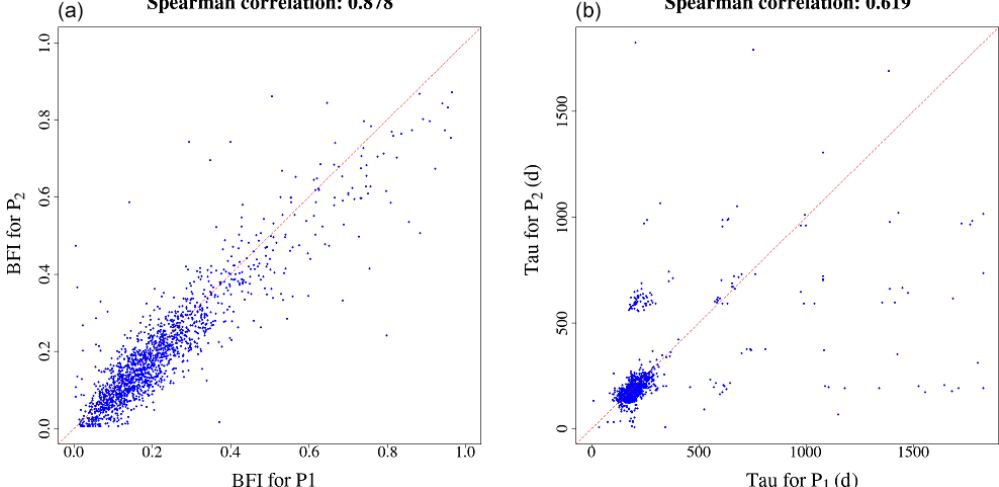
Figure 10. Results of the split-sample test for BFI (a) and τ (b) . Values obtained for P 1 and P 2 are compared.